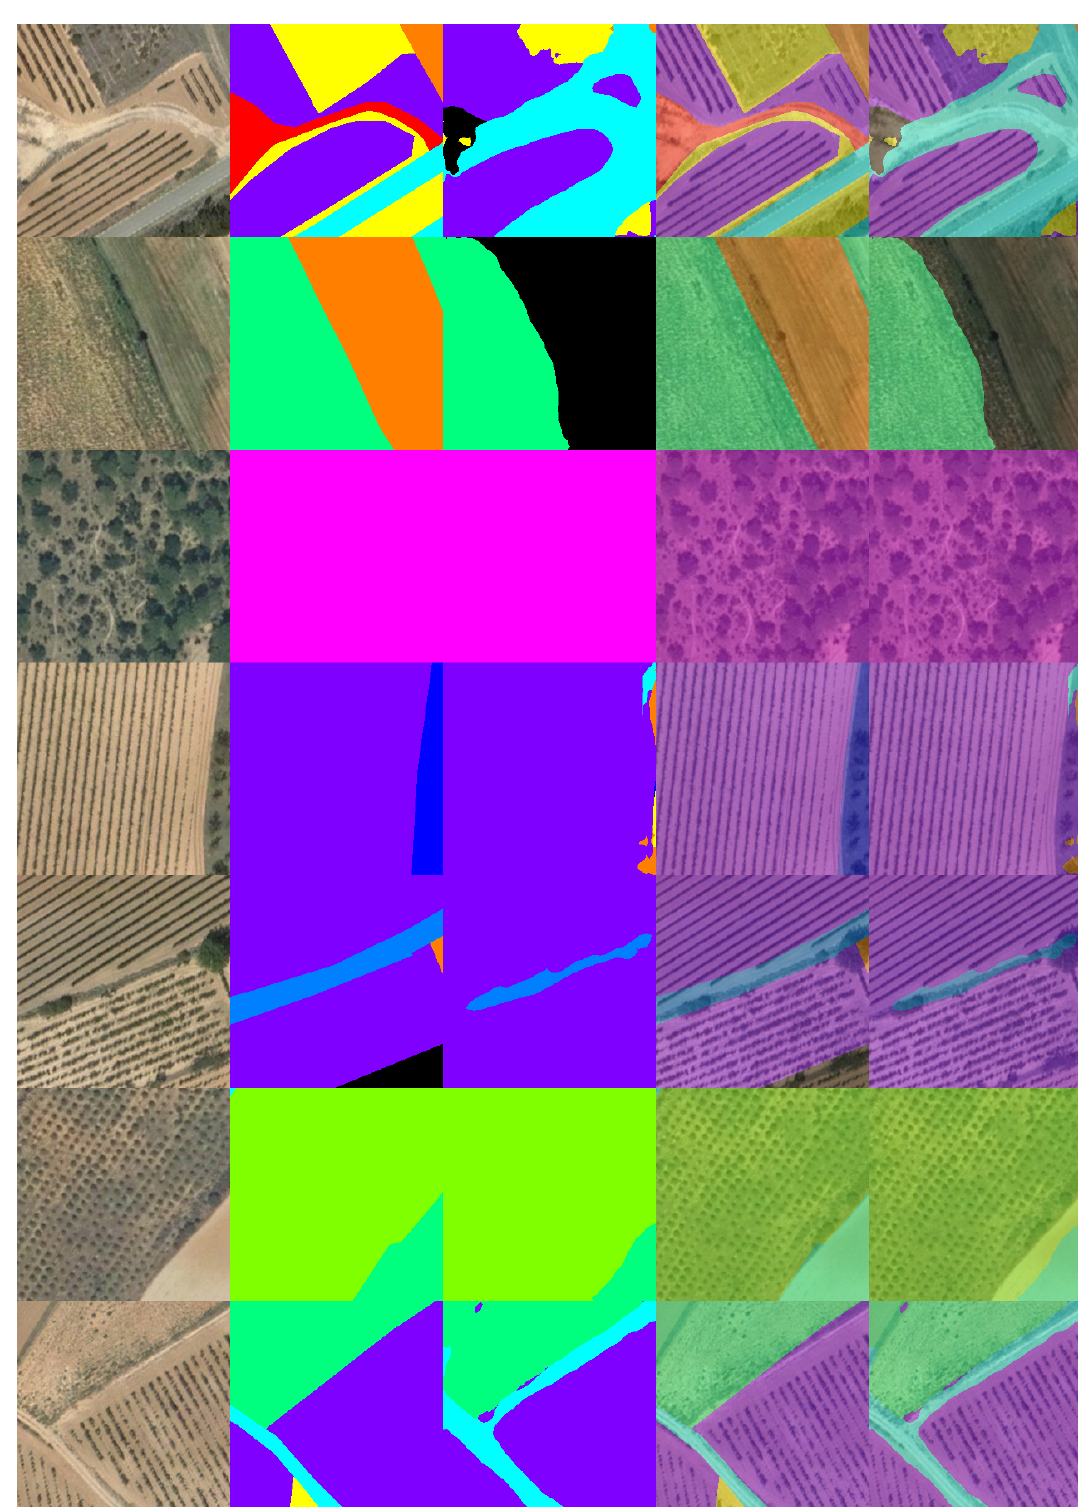
Figure 9. Visualization of the predicted results for DeepLabV3+ evaluated in UOPNOA with “Other” class (Experiment All-Purpose). ( 1st col. ) Original images, ( 2nd col. ) ground truth masks, ( 3rd col. ) predictions, ( 4th col. ) overlapping of original images with ground truth masks, ( 5th col. ) overlapping of original images with